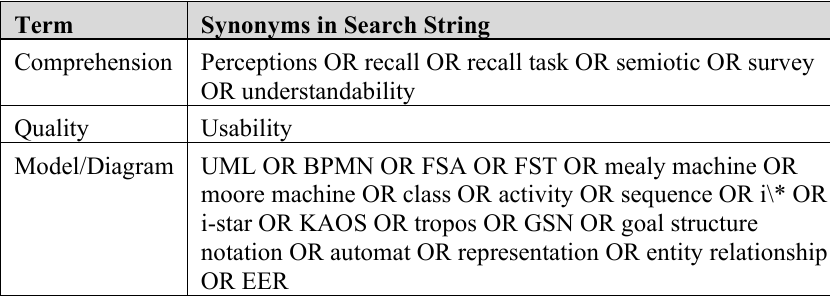
Table 1. Details on the search strings used. These were used in combination, as a single large